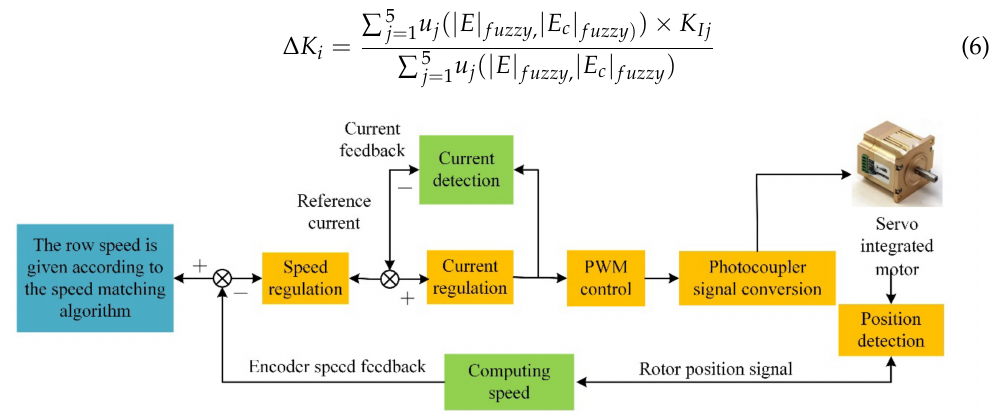
Figure 6. Block diagram of self-tuning double closed-loop fuzzy PID control strategy.